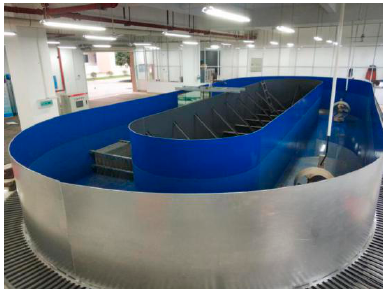
Figure 15. Tidal current tank used for verification test.